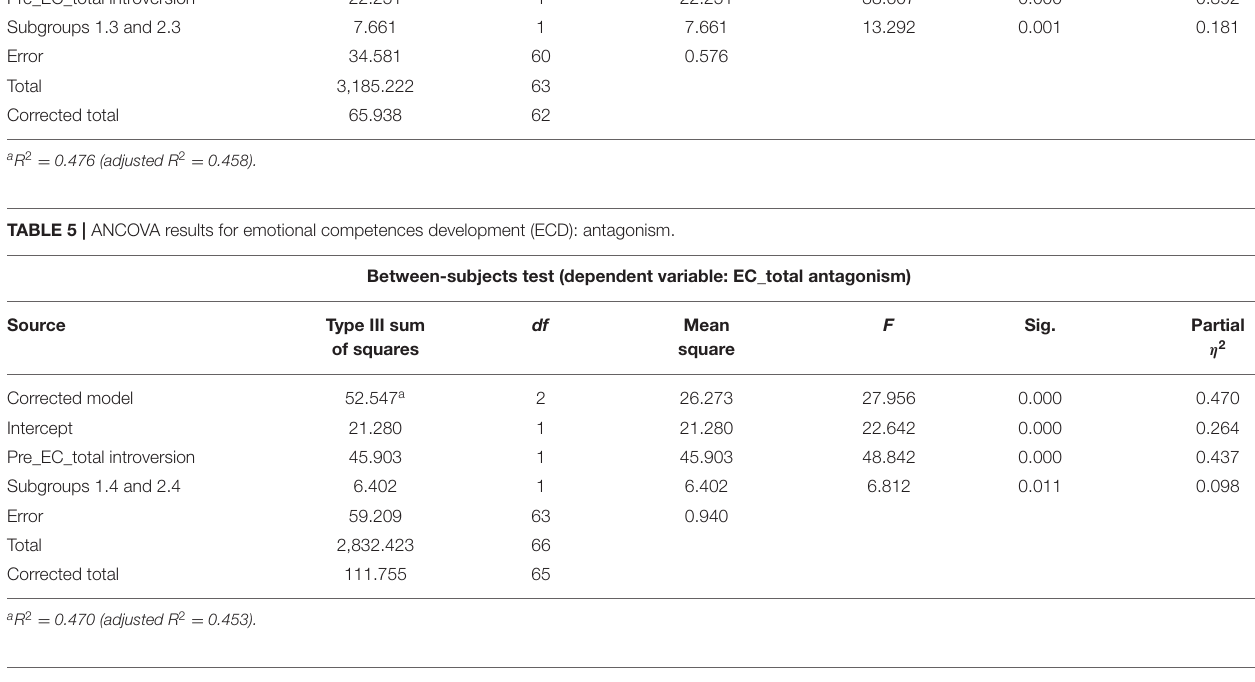
TABLE 6 | ANCOVA results for emotional competences development (ECD): without direction. Between-subjects test (dependent variable EC_total without